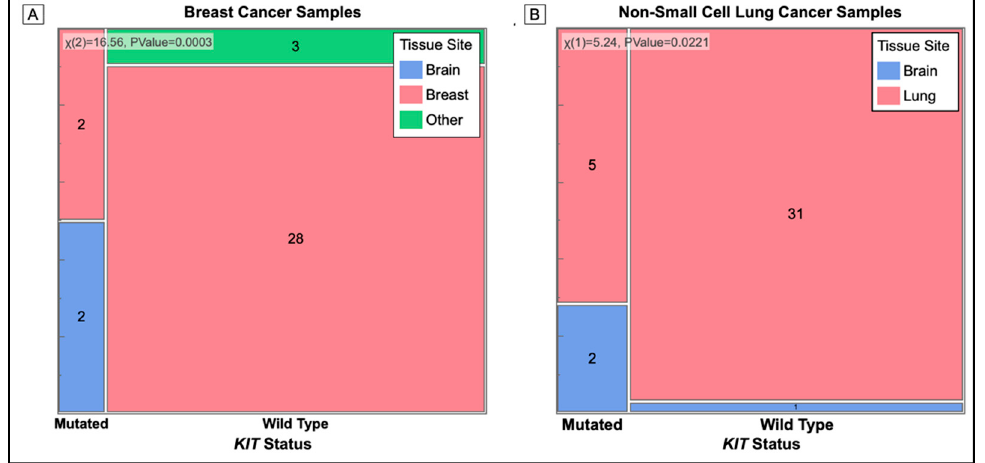
Figure 5. Mosaic Plot of Cancer Tissue Biopsy Site (Primary and Metastatic) used for Mutation Analysis. Cell sizes are proportional to the number of samples in that category. Mutation status is on the X-axis and color represents the tissue sample of origin. ( A ) All KIT mutations occur in biopsy samples of breast cancer taken from the brain. The p -value = 0.0003. ( B ) Biopsy samples taken from the brain have a higher number of KIT mutations than samples from the lung. The p -value = 0.0221.